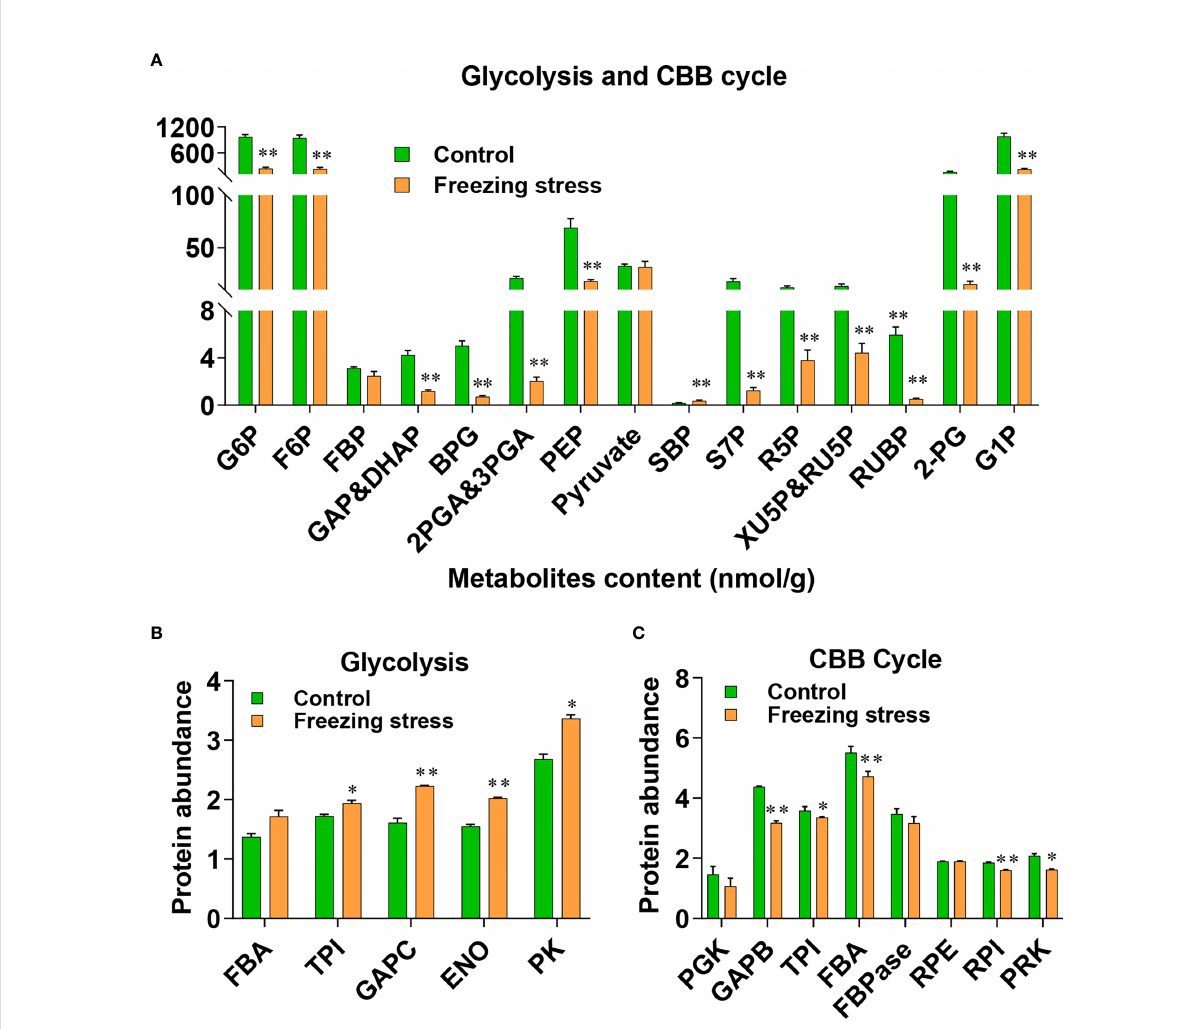
FIGURE 5 Metabolite level and protein abundance analysis of glycolysis pathway and Calvin-Benson (CBB) cycle. (A) Metabolite analysis of glycolysis pathway and CBB cycle. G6P, glucose-6-phosphate; F6P, fructose-6-phosphate; FBP, fructose-1,6-bisphosphate; GAP, glyceraldehydes-3-phosphate; DHAP, dihydroxyacetone-phosphate; BPG, 1,3-biophosphoglycerate; 2PGA, 2-phosphoglycerate; 3PGA, 3-phosphoglycerate; PEP, phosphoenol pyruvate; SBP, sedoheptulose-1,7-bisphosphate; S7P, sedoheptulose-7-phosphate; R5P, ribose-5-phosphate; RU5P, ribulose-5-phosphate; XU5P, xylulose 5-phosphate; RUBP, ribulose-1,5-bisphosphate; 2-PG, 2-phosphoglycolate; G1P, glucose-1-phosphate. Values are means ± SE (n = 6 biological replicates, * P < 0.05, ** P < 0.01 compared with control using Student ’ s t-test). (B, C) Protein abundance of enzymes involved in glycolysis pathway (B) and CBB cycle (C) . FBA, Fructose-1,6-bisphosphate aldolase; TPI, Triose phosphate isomerase; GAPC, glyceraldehyde-3-phosphate dehydrogenase; ENO, enolase; PK, pyruvate kinase; PGK, phosphoglycerate kinase; GAPB, glyceraldehyde-3-phosphate dehydrogenase B; FBPase, fructose-1,6- biphosphatase; RPE, ribulose-5-phosphate-3-epimerase; RPI, ribose 5-phosphate isomerase; Values are means ± SE (n = 3 biological replicates, * P < 0.05, ** P < 0.01 compared with control using Student ’ s